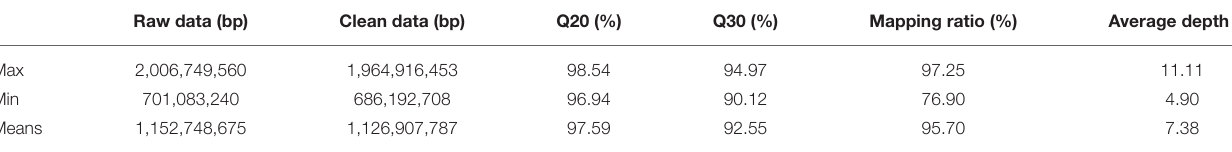
TABLE 3 | Sequencing data statistics and quality assessment.